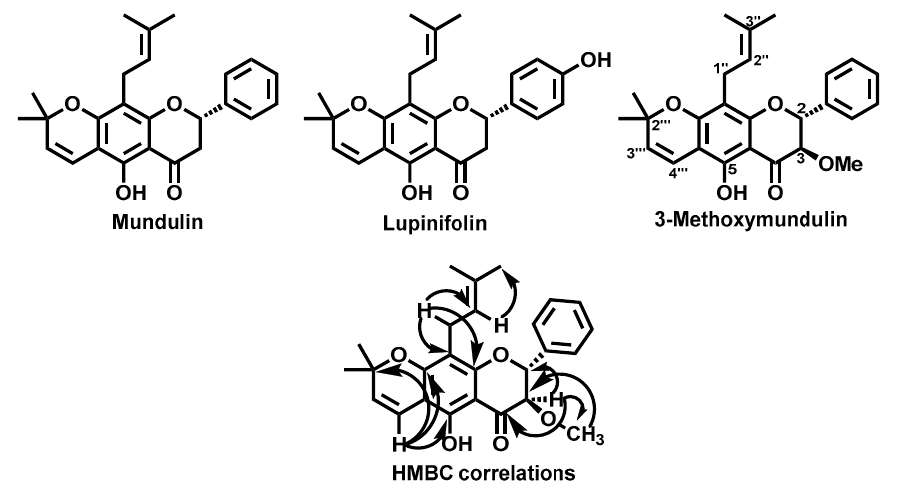
Figure 9. Prenylated flavonoids isolated from G. tridentata roots extract.